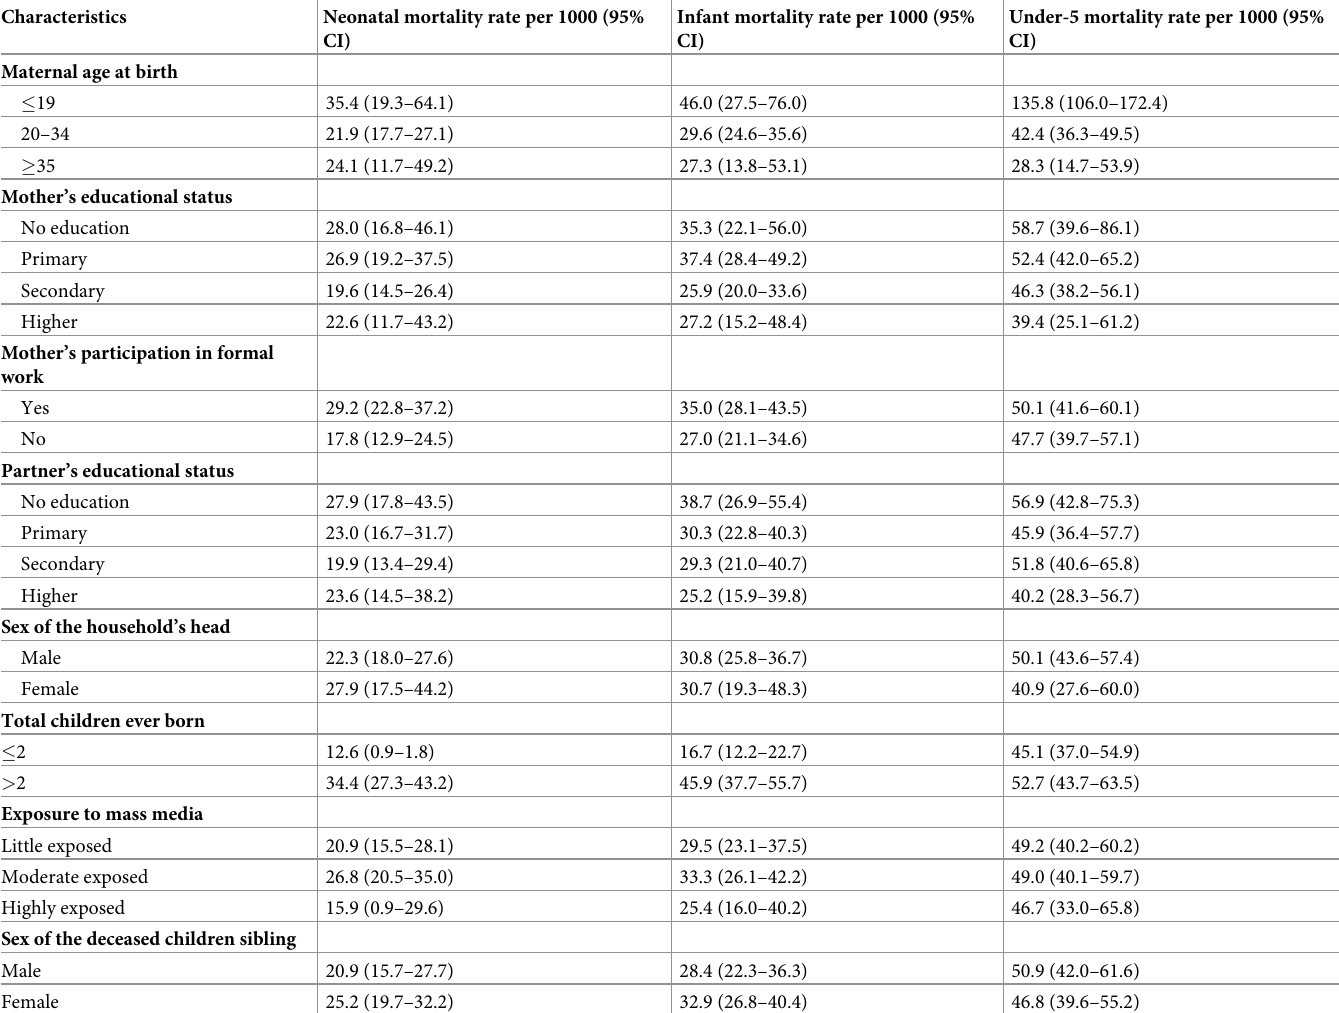
Table 2. Neonatal, infant and under-five mortality rates by background characteristics, BDHS 2017/18.